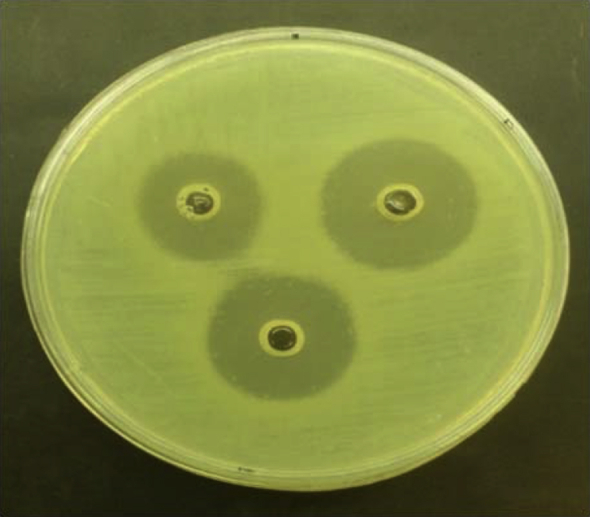
Inhibition zone of P. aeruginosa caused by Lactobacillus spp. (Top left) Lb. fermentum 89-1 (20 mm). (Top right) Lb. plantarum 34-5 (24 mm). (Bottom) Lb. rhamnosus GG (22 mm).